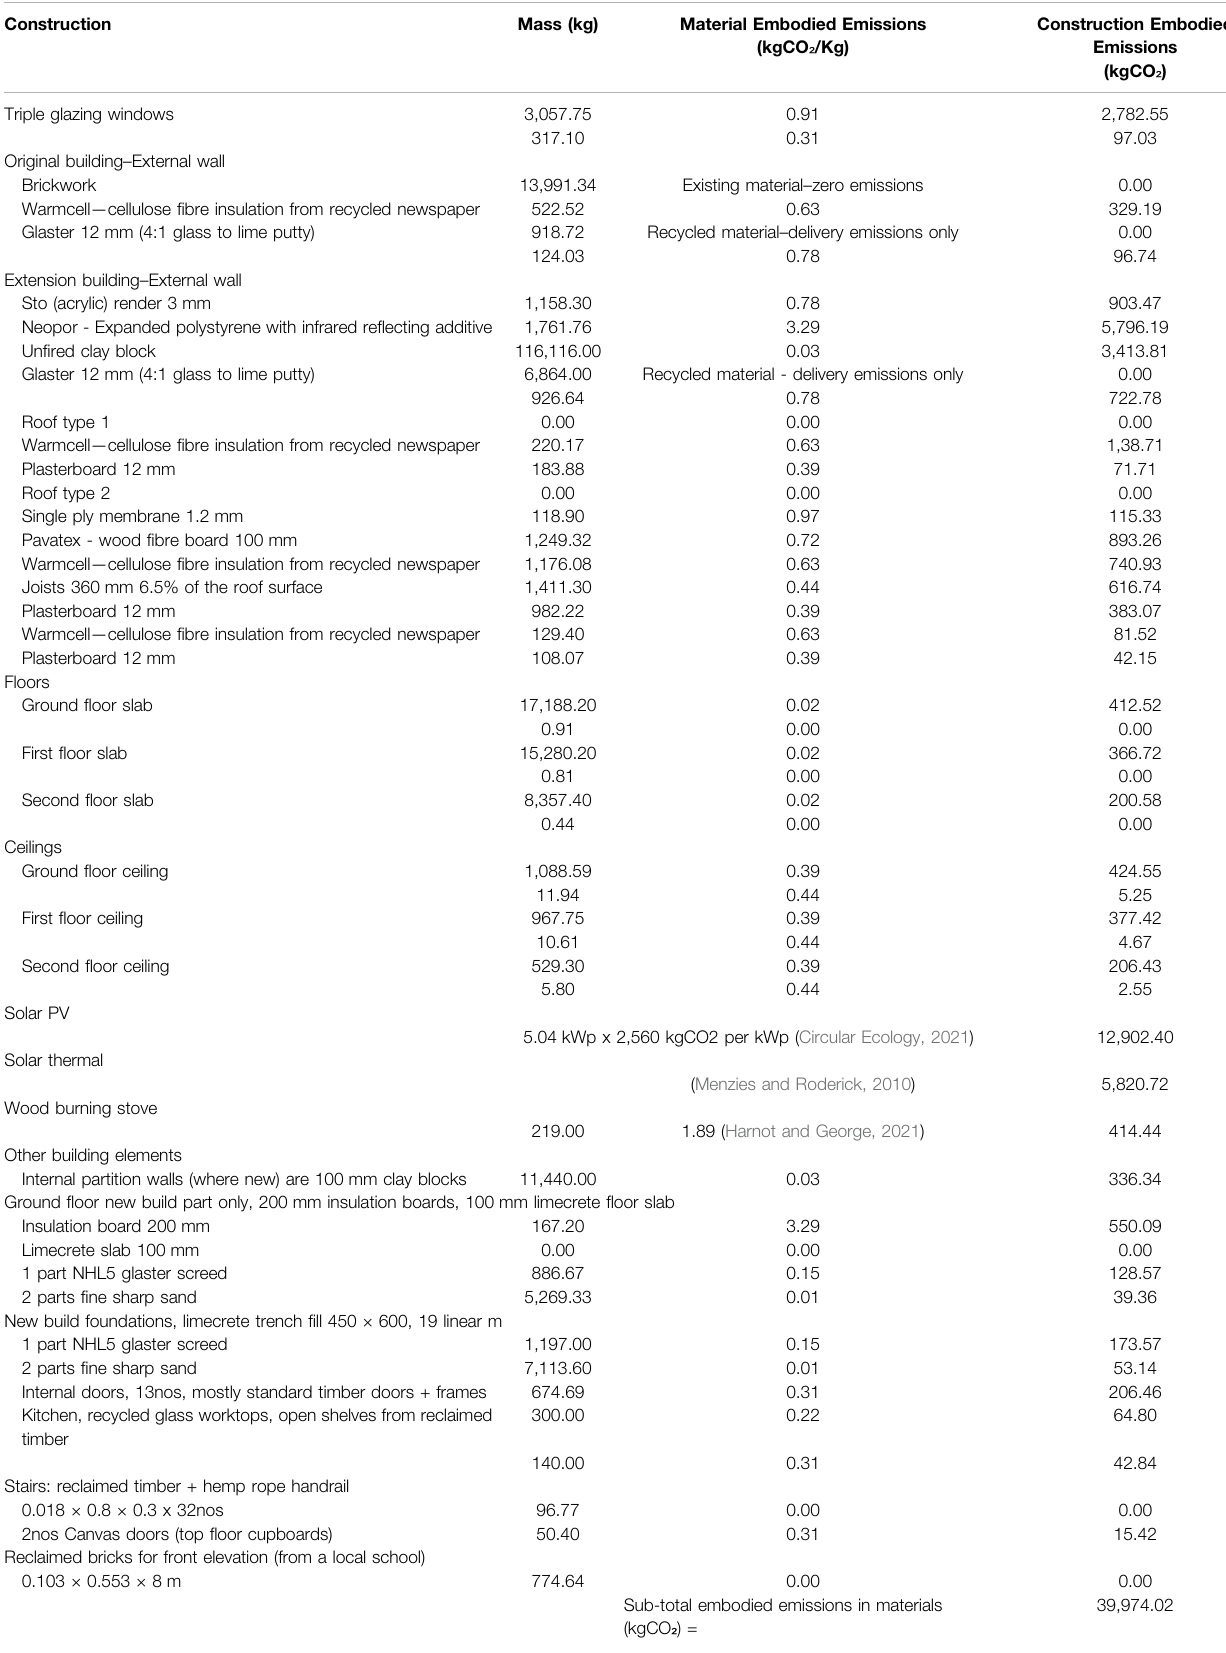
TABLE 3 | Summary calculations of embodied emissions in